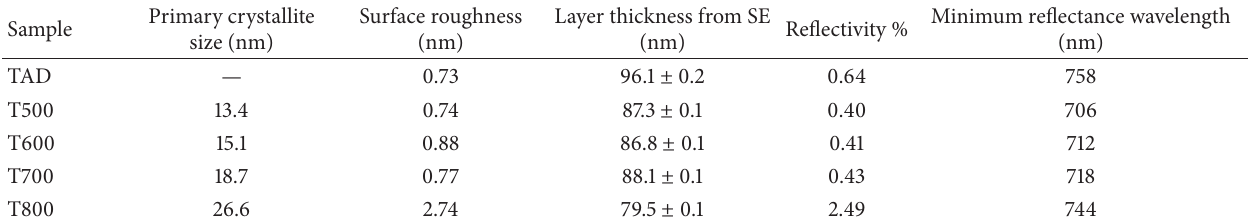
Table 1: Summary of the structural and optical properties of TiO size for annealed samples calculated through the Scherrer equation. Roughness values for 1 𝜇 m × 1 𝜇 m AFM scans for TiO deposited and annealed at various temperatures. Layer thickness obtained from the single layer Cauchy model.